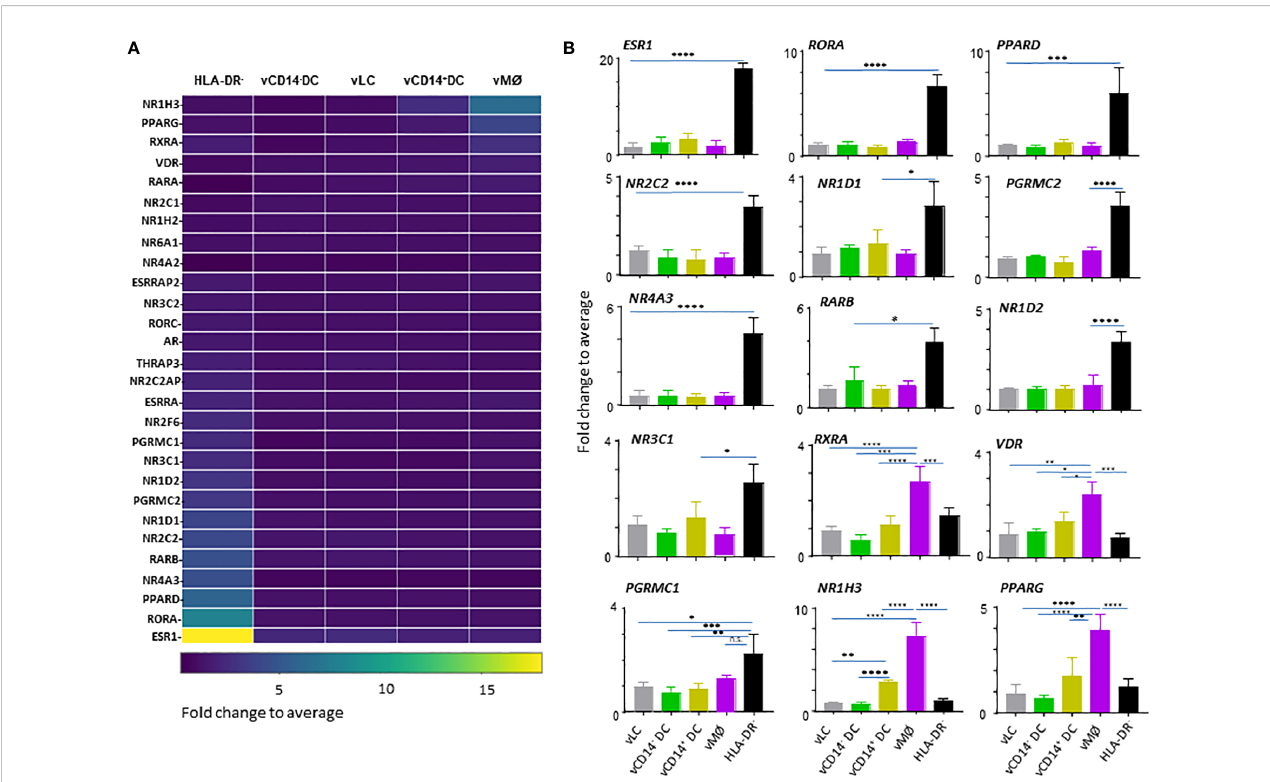
FIGURE 2 HLA-DR - cells in the vaginal tissues express a large array of nuclear hormone receptors (NHRs). (A) Heatmap analysis of NHRs expressed by APC subsets (4 VM APC subsets and HLA-DR - cells in the VM tissues). Unsupervised hierarchical clustering (Pearson correlation) of the 28 NHR transcripts differentially expressed between the 5 populations indicated. (B) Batch-corrected expression values for 15 represented NHR transcripts selected in (A) . Mean ± SD. Statistical analyses were performed with One-way ANOVA. n.s.: not signi fi cant, *p < 0.05, **p < 0.01, ***p < 0.005, ****p <